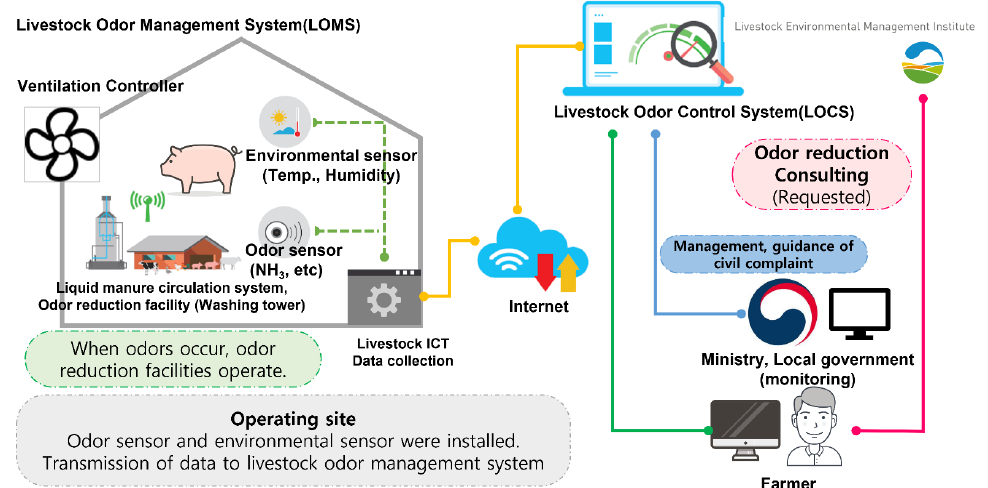
Figure 1. Schematic of livestock odor monitoring system. Livestock odor monitoring systems can be divided into LOMS and LOCS. LOMS can be measured by attaching a sensor where ammonia is generated, such as livestock farms. LOCS refers to a system that can receive and check measured data and link the two systems using Internet communication equipment.